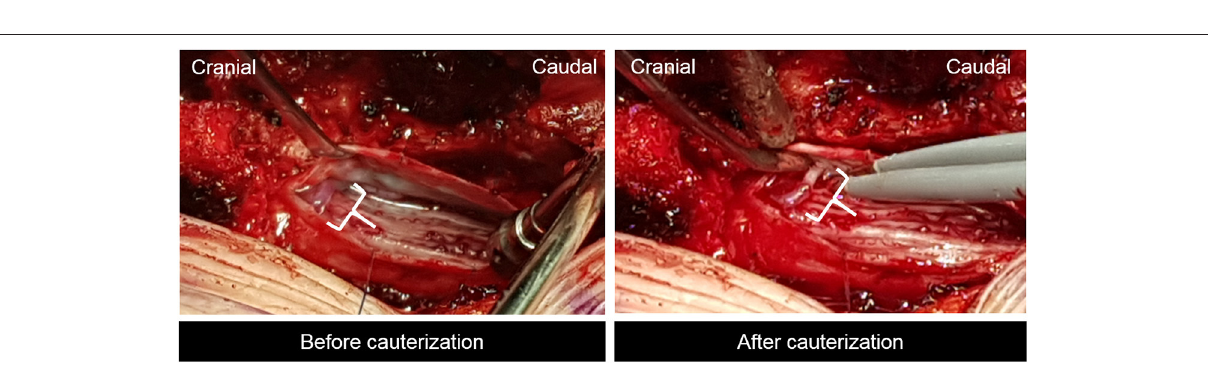
FIGURE 4 | Intraoperative finding revealing intradural arteriovenous